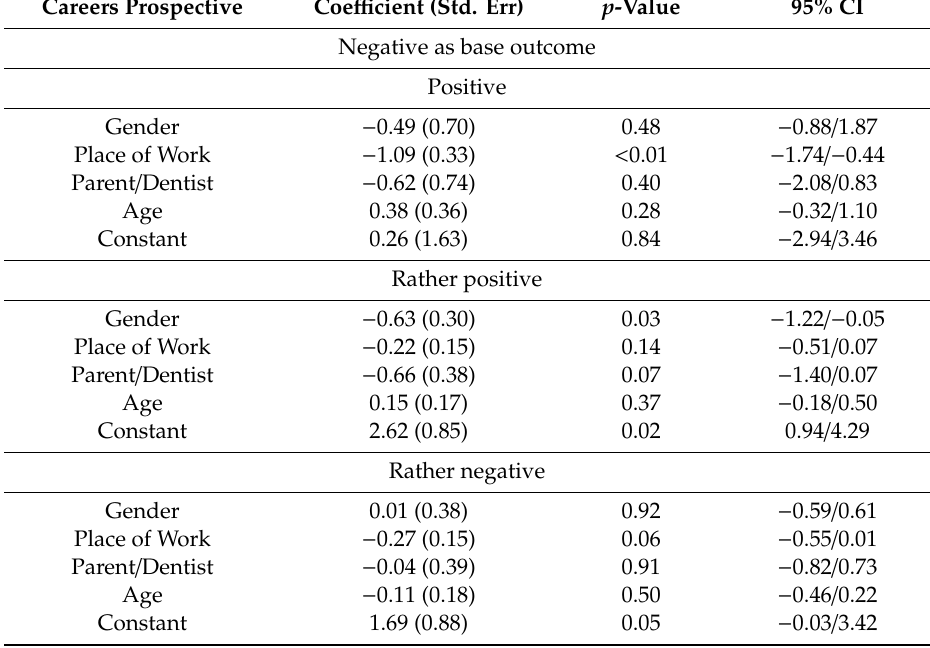
Table 4. Multinomial regression analysis. Career Prospects (Positive / Rather Positive / Rather positive / Negative). Negative prospect as base